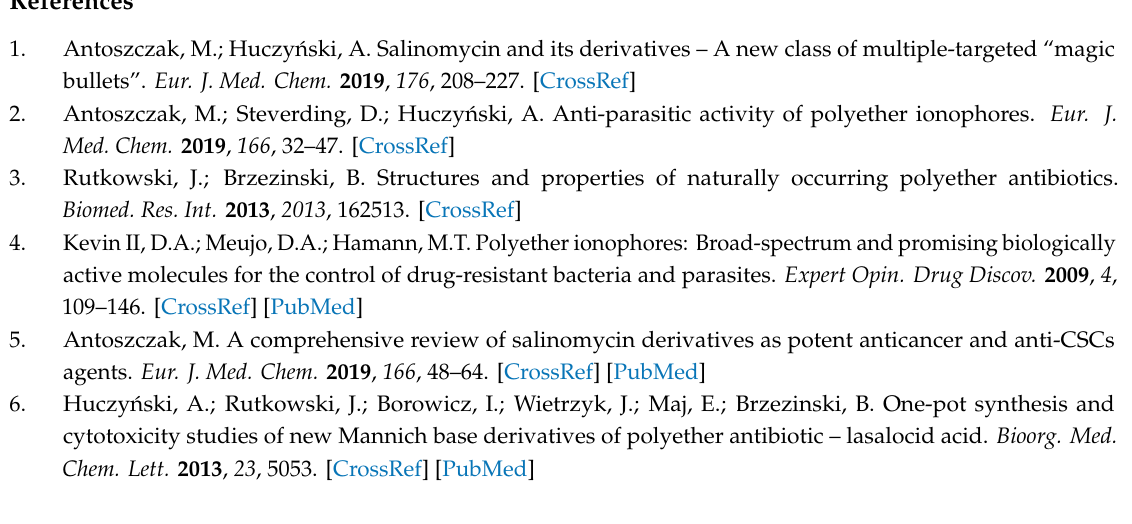
Figure S1: The 1 H NMR spectrum of 4 in dichloromethane-d 2 , Figure S2: The 13 C NMR spectrum of 4 in dichloromethane-d 2 , Figure S3: The 1 H NMR spectrum of 5 in chloroform-d, Figure S4: The 13 C NMR spectrum of 5 in chloroform-d, Figure S5: The 1 H NMR spectrum of 10 in chloroform-d, Figure S6: The 13 C NMR spectrum of 10 in chloroform-d, Figure S7: The 1 H NMR spectrum of 14 in chloroform-d, Figure S8: The 13 C NMR spectrum of 14 in chloroform-d, Figure S9: The 1 H NMR spectrum of 15 in chloroform-d, Figure S10: The 13 C NMR spectrum of 15 in chloroform-d, Figure S11: The 1 H NMR spectrum of 16 in chloroform-d, Figure S12: The 13 C NMR spectrum of 16 in chloroform-d, Figure S13: The 1 H NMR spectrum of 17 in chloroform-d, Figure S14: The 13 C NMR spectrum of 17 in chloroform-d, Figure S15: The 1 H NMR spectrum of 18 in chloroform-d, Figure S16: The 13 C NMR spectrum of 18 in chloroform-d, Figure S17: The 1 H NMR spectrum of 19 in chloroform-d, Figure S18: The 13 C NMR spectrum of 19 in chloroform-d, Figure S19: The 1 H NMR spectrum of 20 in chloroform-d, Figure S20: The 13 C NMR spectrum of 20 in chloroform-d, Figure S21: The 1 H NMR spectrum of 21 in chloroform-d, Figure S22: The 13 C NMR spectrum of 21 in chloroform-d, Figure S23: The 1 H NMR spectrum of 22 in chloroform-d, Figure S24: The 13 C NMR spectrum of 22 in chloroform-d, Figure S25: The 1 H NMR spectrum of 23 in chloroform-d, Figure S26: The 13 C NMR spectrum of 23 in chloroform-d, Figure S27: The 1 H NMR spectrum of 24 in chloroform-d, Figure S28: The 13 C NMR spectrum of 24 in chloroform-d, Figure S29: The ESI mass spectra of a mixture of 14 , 15 , 16 and 17 with NaClO 4 at cv = 30 V, Figure S30: The ESI mass spectra of a mixture of 18 , 19 , 20 and 21 with NaClO 4 at cv = 30 V, Figure S31: The ESI mass spectra of a mixture of 22 , 23 , and 24 with NaClO 4 at cv = 30 V, Table S1: The yields of the synthesis, and the analytical bands in the FT-IR spectra (wavenumbers in cm –1 ) and signals in the 1 H and 13 C NMR spectra ( δ in ppm) of propargyl and azide partners for the CuAAC reaction, Table S2: The yields of the synthesis, and the analytical signals in the 1 H and 13 C NMR spectra of novel dimeric polyether